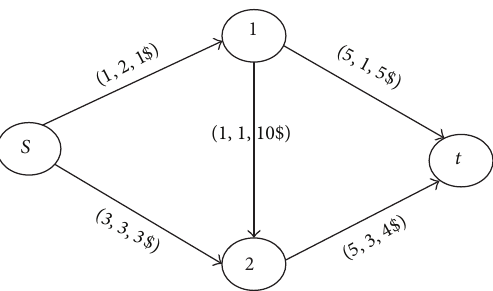
Figure 1: An example of network flow; arc labels present as (𝑢 𝑖𝑗 ,𝑀 𝑖𝑗 ,𝑐 𝑖𝑗 ) .